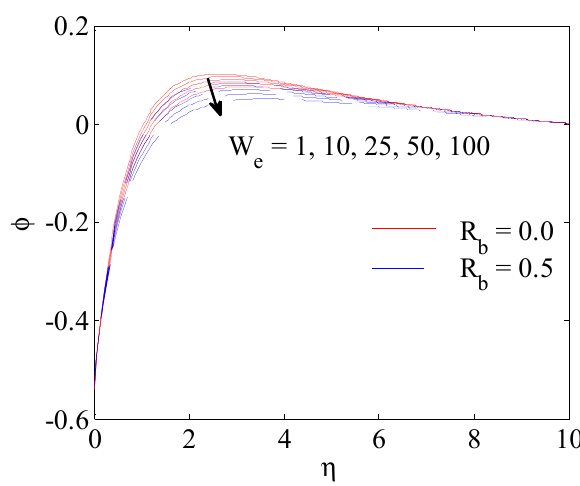
Figure 11. Fluctuations of φ due to the factor W e .